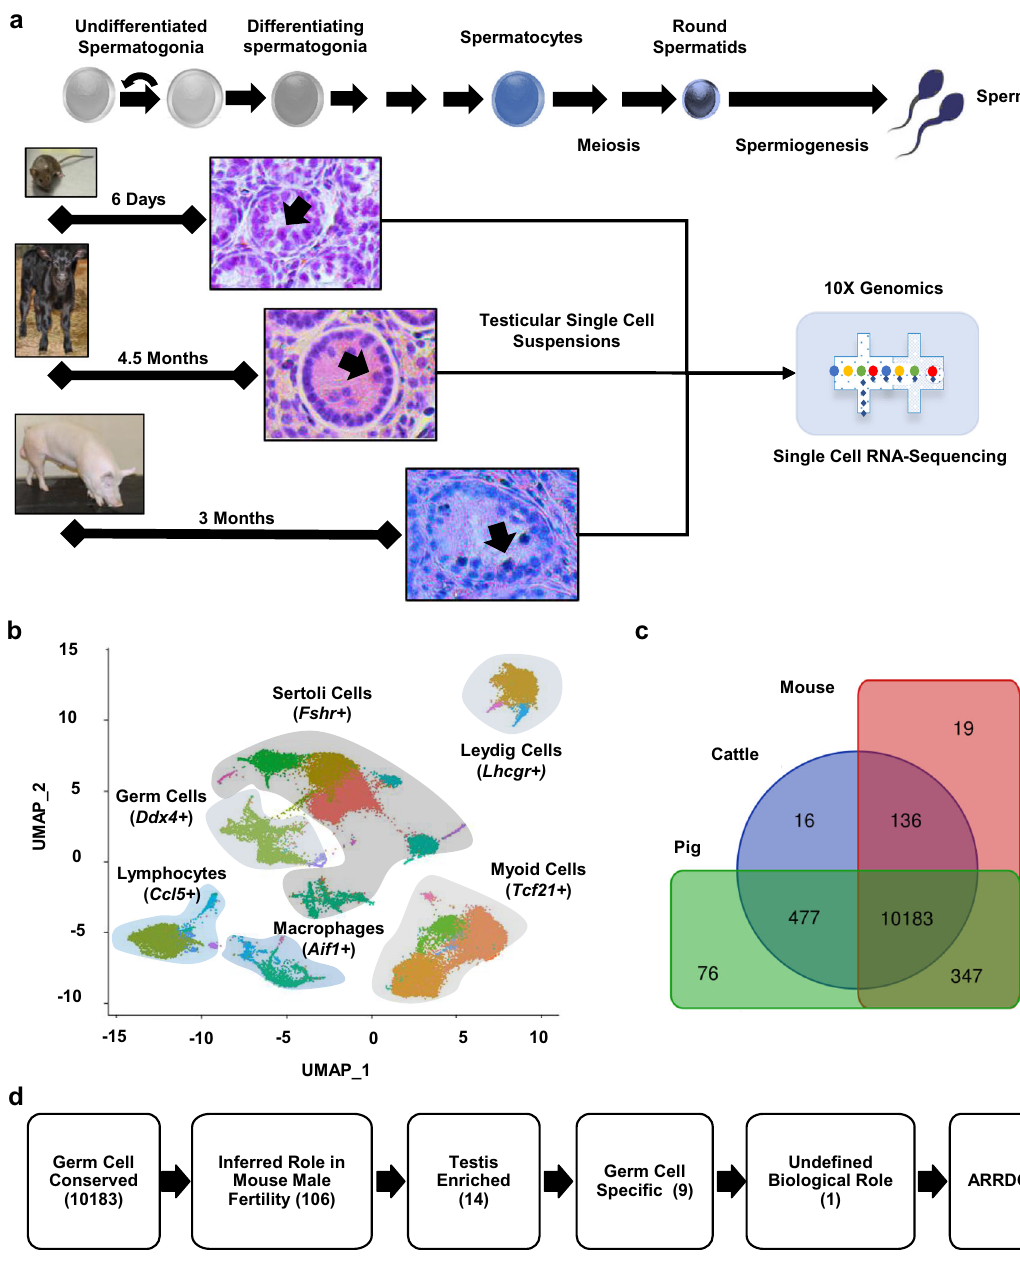
Fig. 1 | Generation of a multispecies integrated testicular single-cell tran- scriptome database. a Schematic of the experimental strategy that analyzed tes- ticulartissuefromprepubertalmice,cattle,andpigsbysingle-cellRNA-sequencing. Representative images of hematoxylin and eosin-stained testicular cross-sections are shown, arrows denote germ cells within seminiferous tubules. b Integrated uniform manifold approximation and projection (UMAP) plot for ~48,000 testi- cularcellsfrom three species. Distinctclustersof testicularcell types werede fi ned